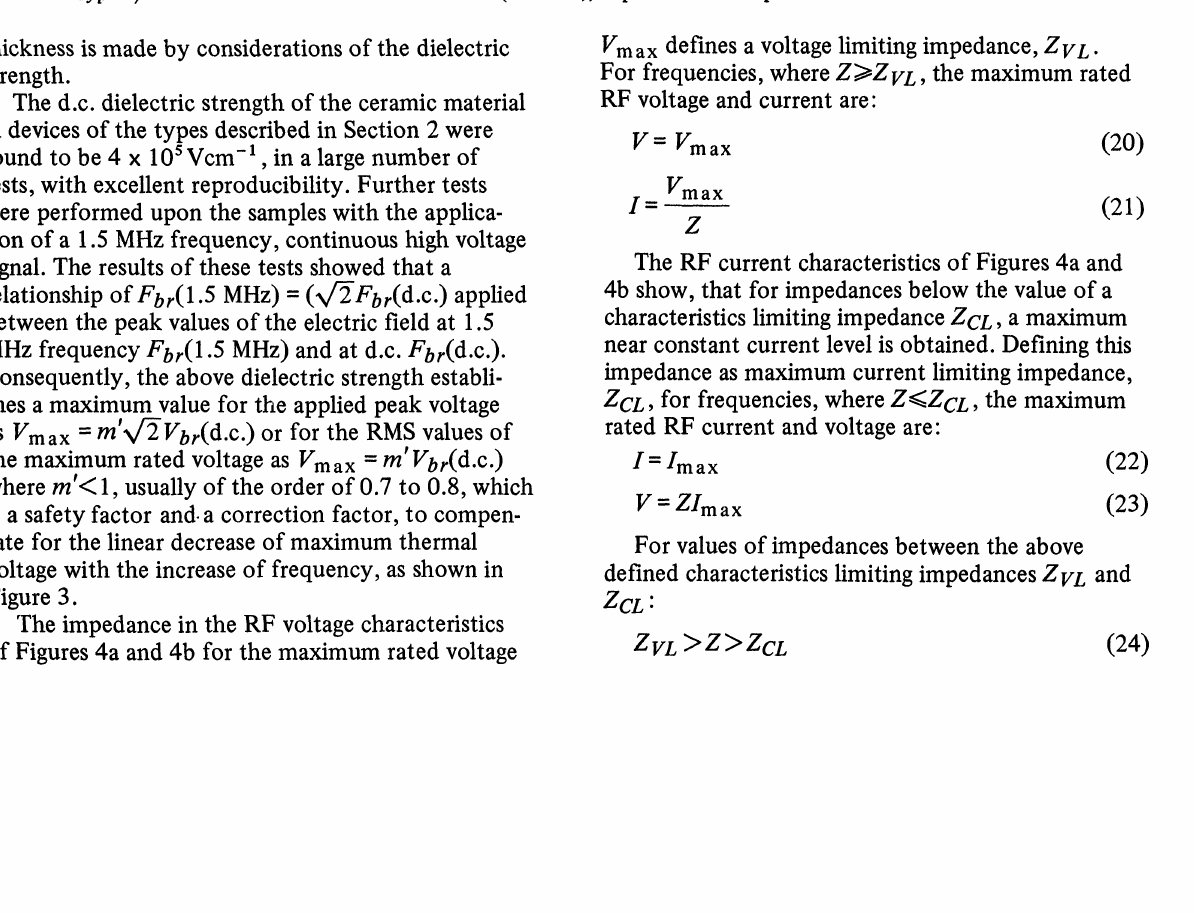
RF current and voltage vs. frequency characteristics of monolithic ceramic capacitor active layer, upon the onset of thermal runaway in the temperature difference between central plane of the dielectric and electrode. Type a) device. Dielectric thickness: 0.254 mm (0.010 in), Capacitance: 41.8